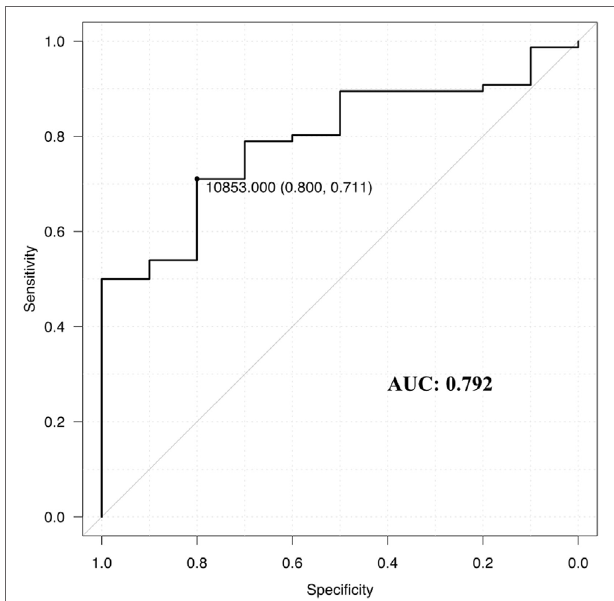
FigUre 7 | Receiver operating characteristics curve for determining the efficacy of the spectrometry for talaporfin sodium. The specificity and sensitivity were 0.80 and 0.71, respectively, when the fluorescence intensity threshold was set at 10,853 (arbitrary units) for discriminating samples of histopathological class 0, defined as tumor-negative. Area under the curve (AUC) = 0.792, 95% confidence interval: